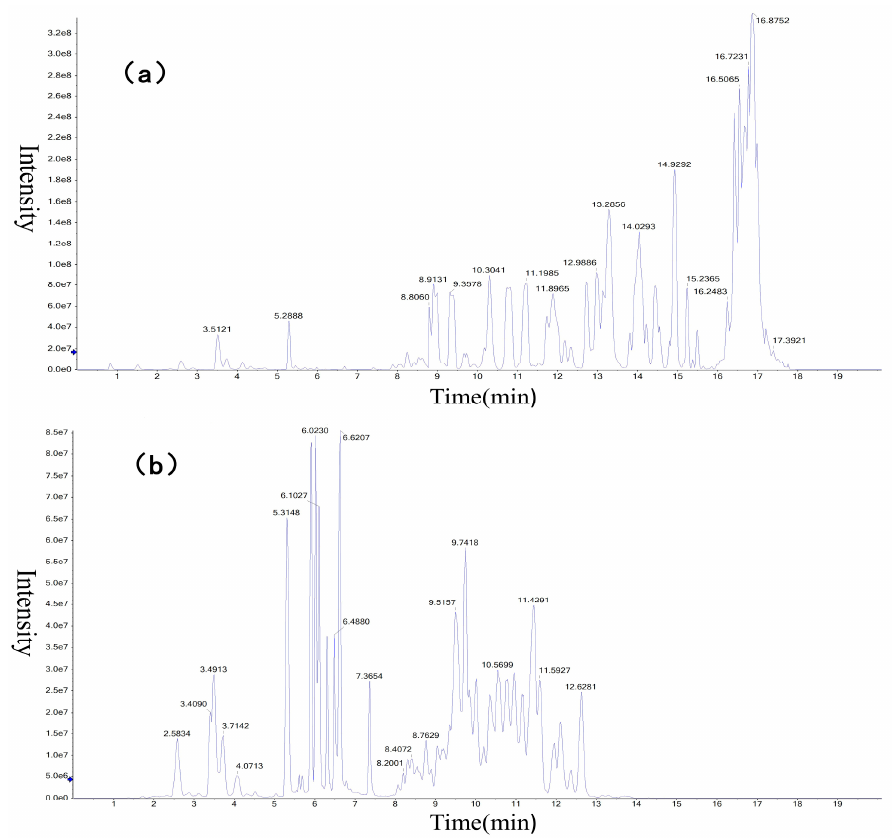
Figure 1. Total ion chromatogram of liver metabolites in ( a ) ES(+) mode and ( b ) ES( − ) mode. 8.0 e7 of the ordinate means 8 × 10 7 , the other numbers are the same.